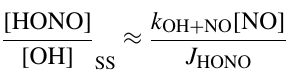
Figure 7. Average measurements of HONO, OH, HONO / OH, J NO and (b) the urban site. Mixing ratios of NO at the forested site were estimated based on previous measurements of the NO / NO 2 ratio at this site (dashed green line). During the measurement period conducted at the urban site, the detection cell was partially shaded by the building during the morning and early afternoon, resulting in the observed peak in J NO diurnal average measurements (1 σ